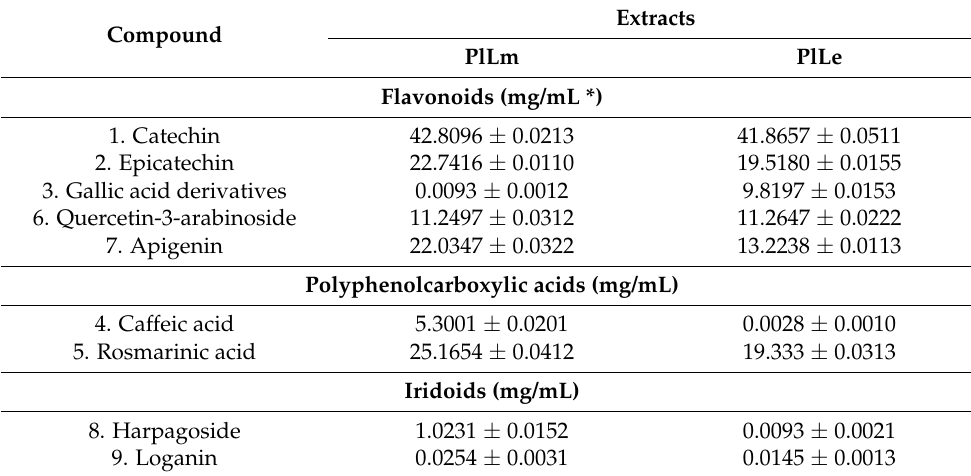
Table 2. Phytochemical analysis of Polyalthia longifolia leaf extracts.